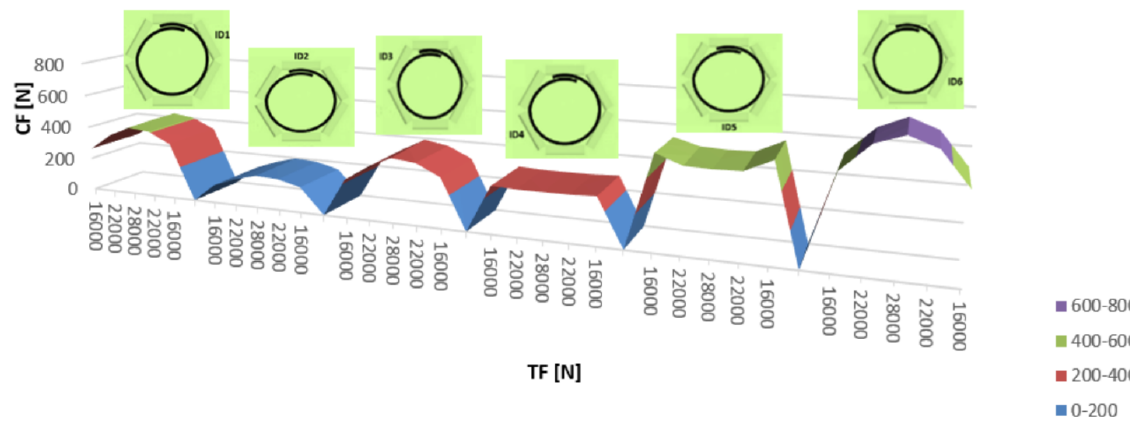
Figure 8: The course of CF for hexagonal idler housing No.1